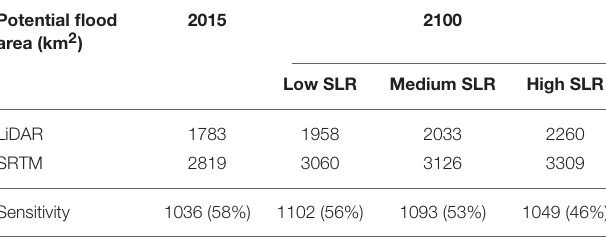
TABLE 6 | 100-year floodplain under three different SLR scenarios using LiDAR and SRTM (today and in 2100). Potential flood area (km 2